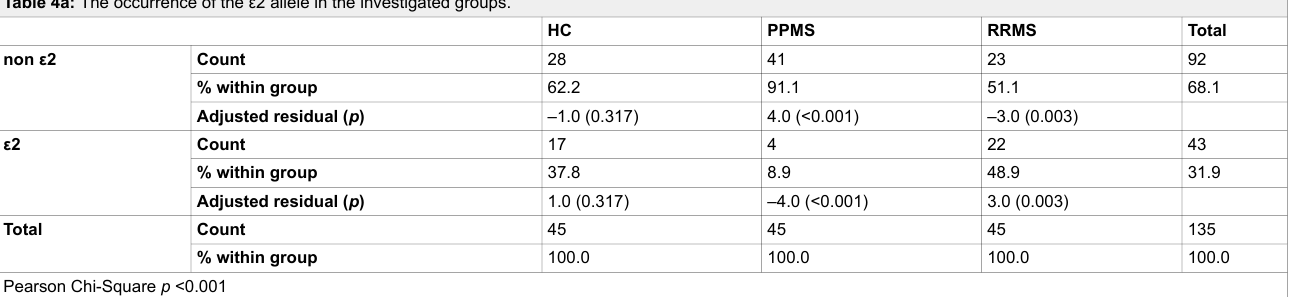
Table 4a: The occurrence of the ε2 allele in the investigated groups.